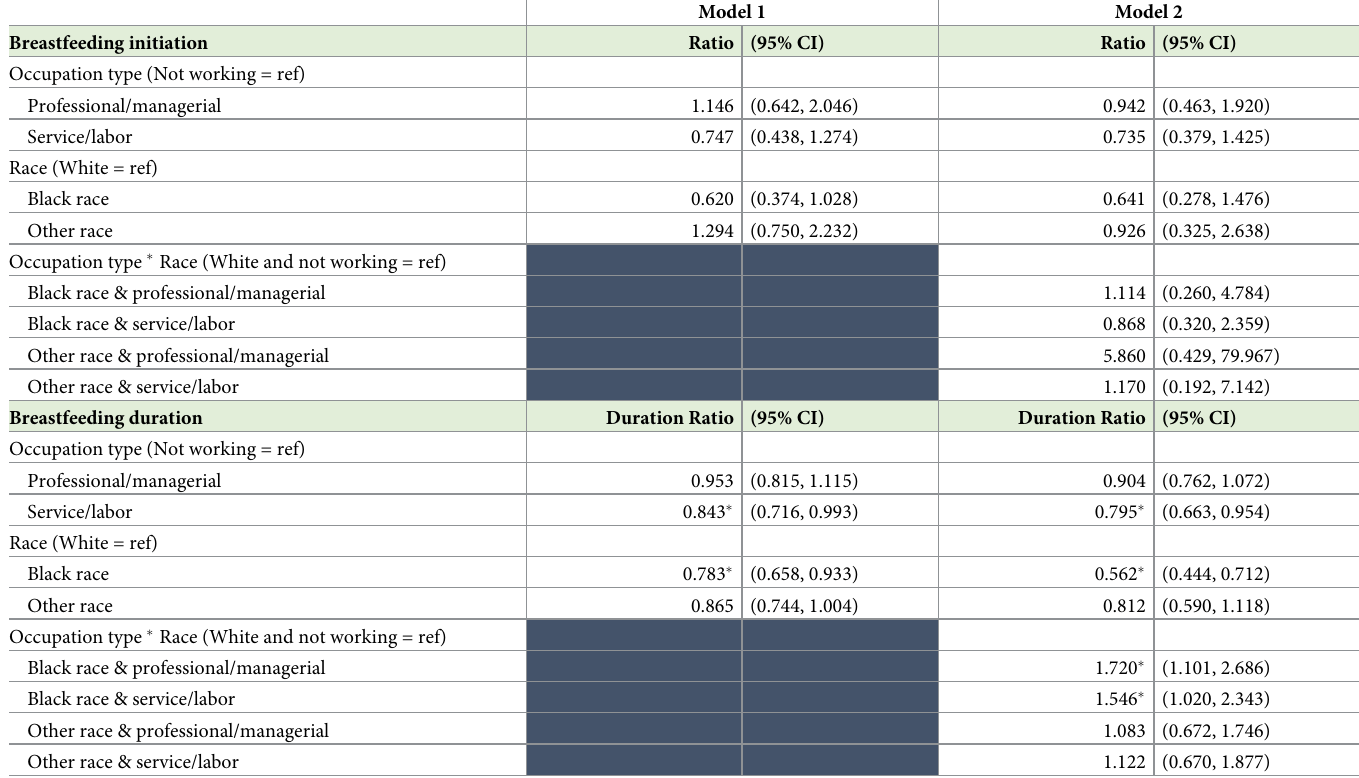
Table 2. Breastfeeding duration and initiation by mother’s employment status/occupation type and